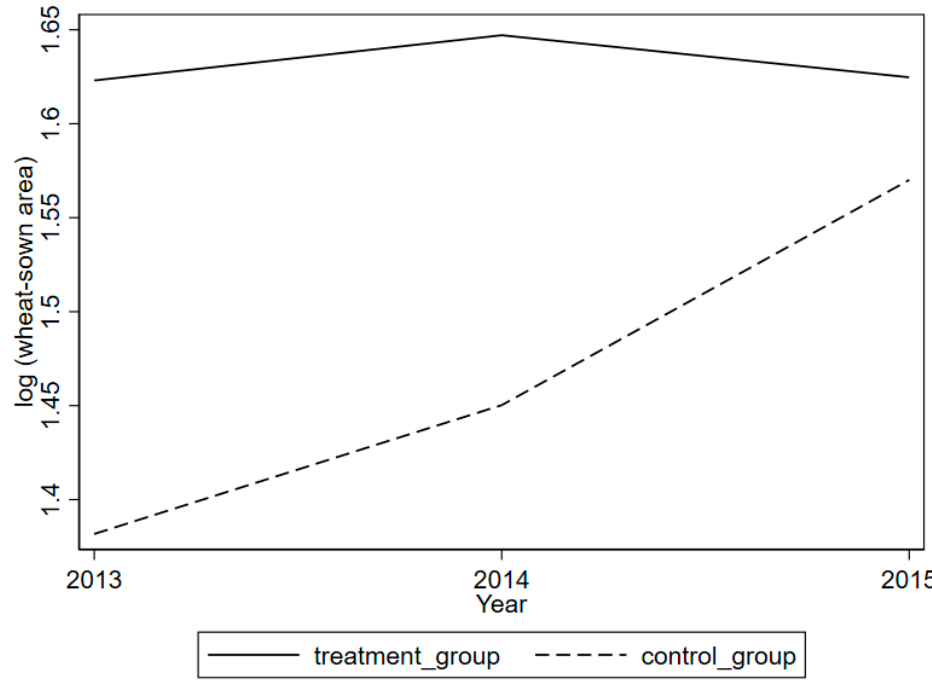
Figure 4. Result of parallel trends test.